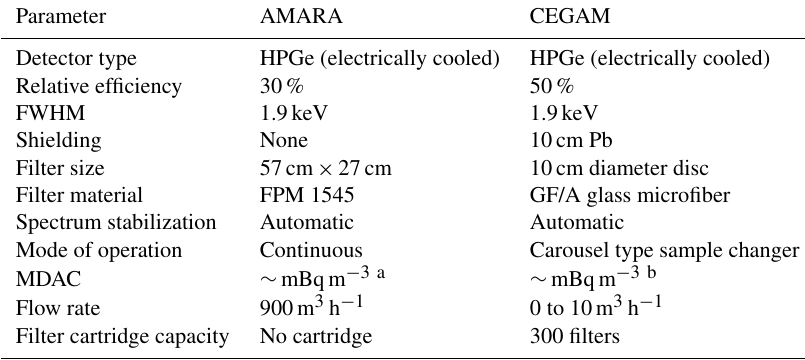
Table 1. Technical specification of the AMARA and CEGAM systems. FWHM: full width at half maximum. Parameter